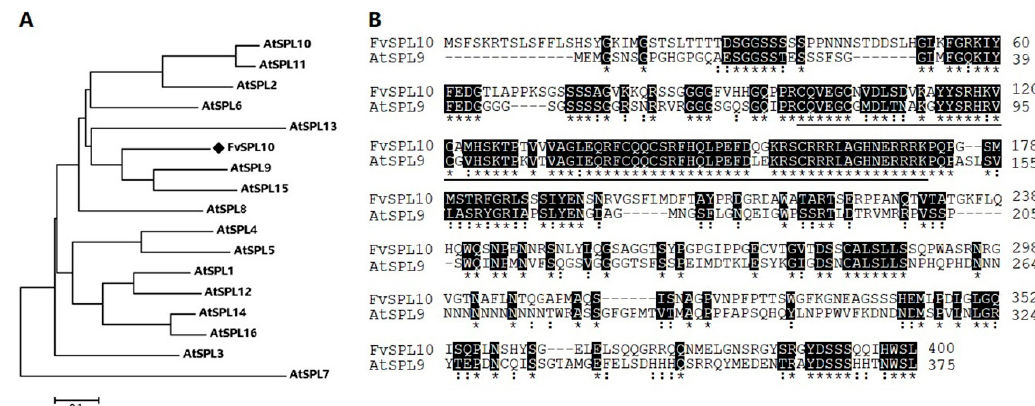
Figure 1. Bioinformatic analysis of FvSPL10 . ( A ) The amino acid sequences of FvSP10 and 16 AtSPLs were aligned using the Clustal W algorithm, and the neighbor-joining tree was constructed by MEGA6.0 software with 1000 bootstrap replicates. The scale bar represents a distance of 0.1 substitutions per site. FvSPL10 is marked with a diamond. ( B ) Amino acid sequences alignment of FvSPL10 and AtSPL9 . Identical amino acids were highlighted in black and marked by star, and similar amino acids were marked by double dots. In addition, the conserved SQUAMOSA -promoter-binding (SBP) domain in their sequences is underlined.